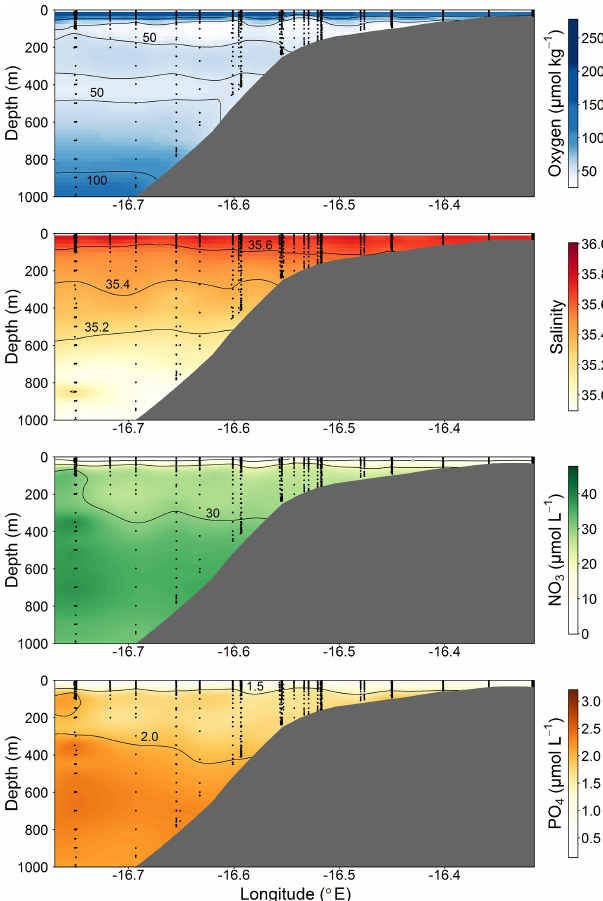
Figure 2. Section plots of oxygen (µmolkg − 1 ), salinity (PSU), NO 3 (µmolL − 1 ), and PO 4 (µmolL − 1 ) along the transect off the Mauritanian coast in June